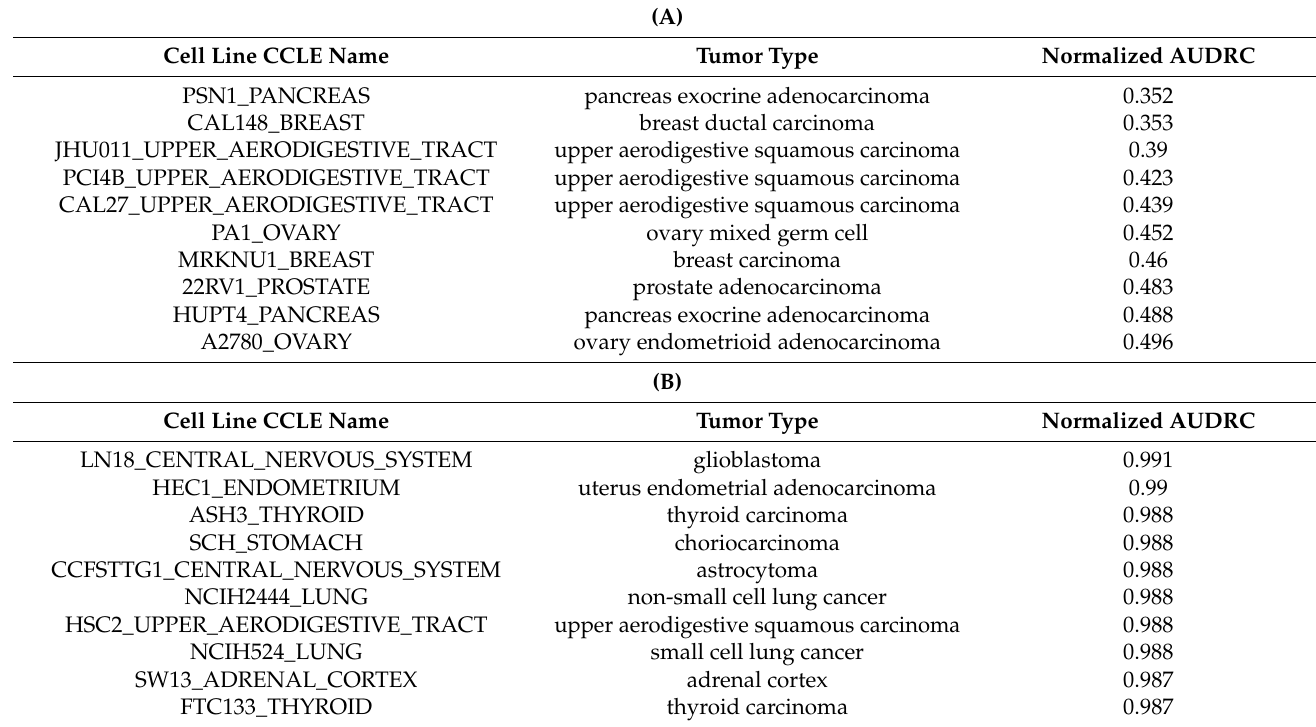
Table 1. The top ten 5-fluorouracil sensitive (A) and resistant (B) solid tumor cell lines in the GDSC database. A lower AUDRC (area under the dose–response curve) value indicates higher sensitivity, while a higher AUDRC value indicates greater resistance.